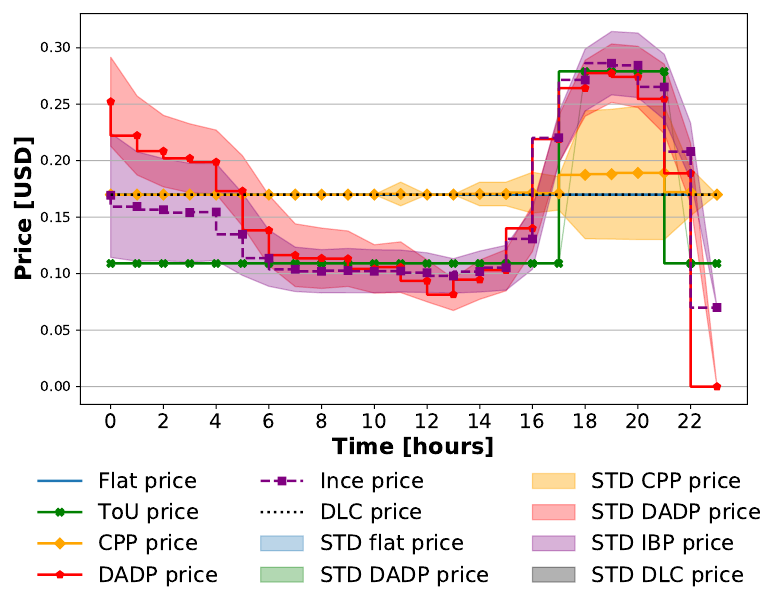
Figure 7. Daily average price of the selected tariffs.